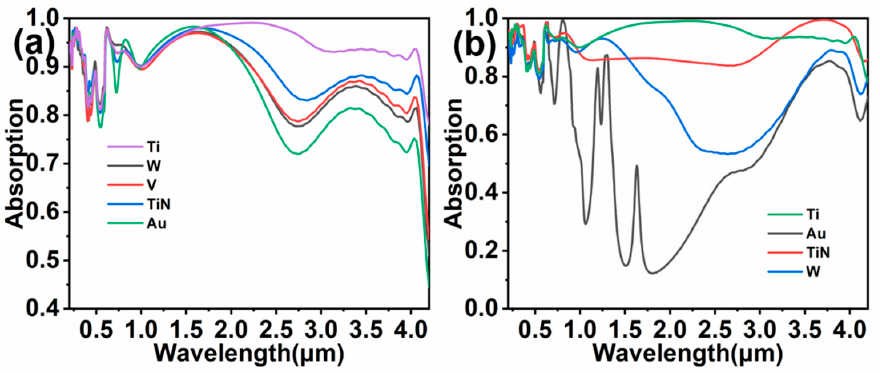
Figure 8. Absorption spectra of solar energy absorber with different substrates ( a ) and different filling materials in between the sphere cavity and substrate ( b ), respectively.